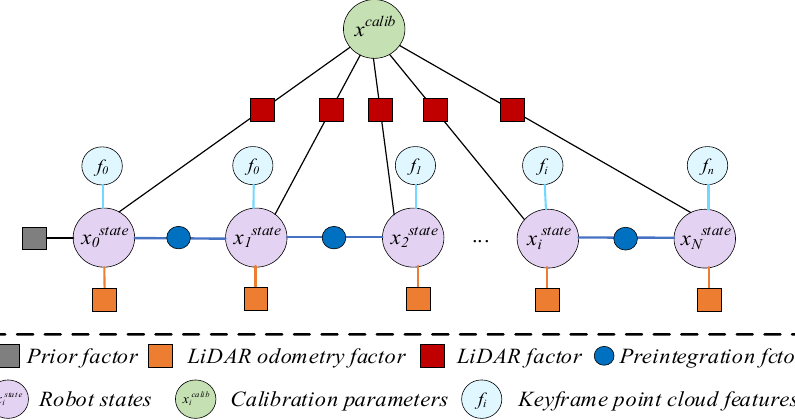
Figure 5. Multisensor spatiotemporal calibration factor graph model.